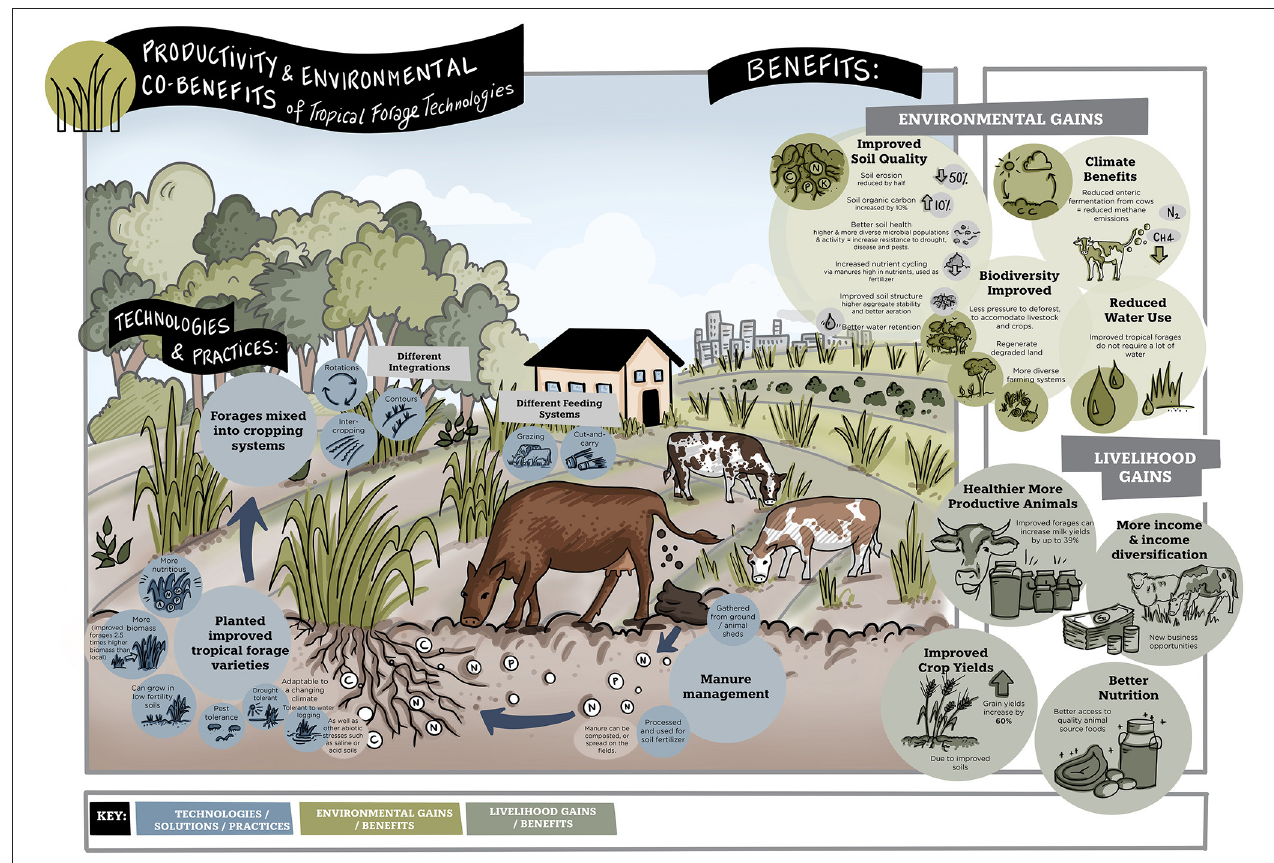
FIGURE 2 | Productivity and environmental co-benefits of tropical forage